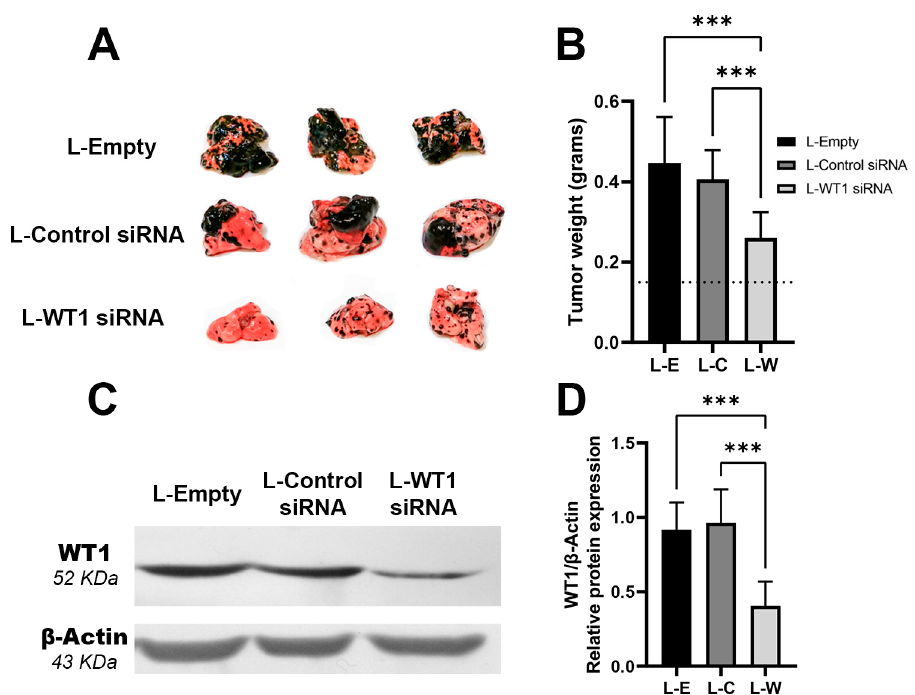
Figure 4. Respiratory administration of liposomal WT1 siRNA reduces the tumor size by decreasing WT1 protein expression in a lung metastatic melanoma model in mice. ( A ) L-WT1 siRNA administration reduces the size of the tumor and number of metastases in the lungs after 2 weeks of treatment. ( B ) There is a decrease in the weight of the lungs treated with L-WT1 siRNA when compared with control groups. Dot line represents average weight of a healthy tumor as a reference. ( C ) WT-1 protein expression is reduced in the lung’s melanoma metastases of the L-WT1 siRNA-treated group observed via a WB and ( D ) WT-1 quantification via densitometry of the bands. Groups L-E: L-Empty, L-C: L-Control siRNA, L-W: L-WT1 siRNA. One-way ANOVA was used as statistical test for group’s comparison. *** p < 0.001.